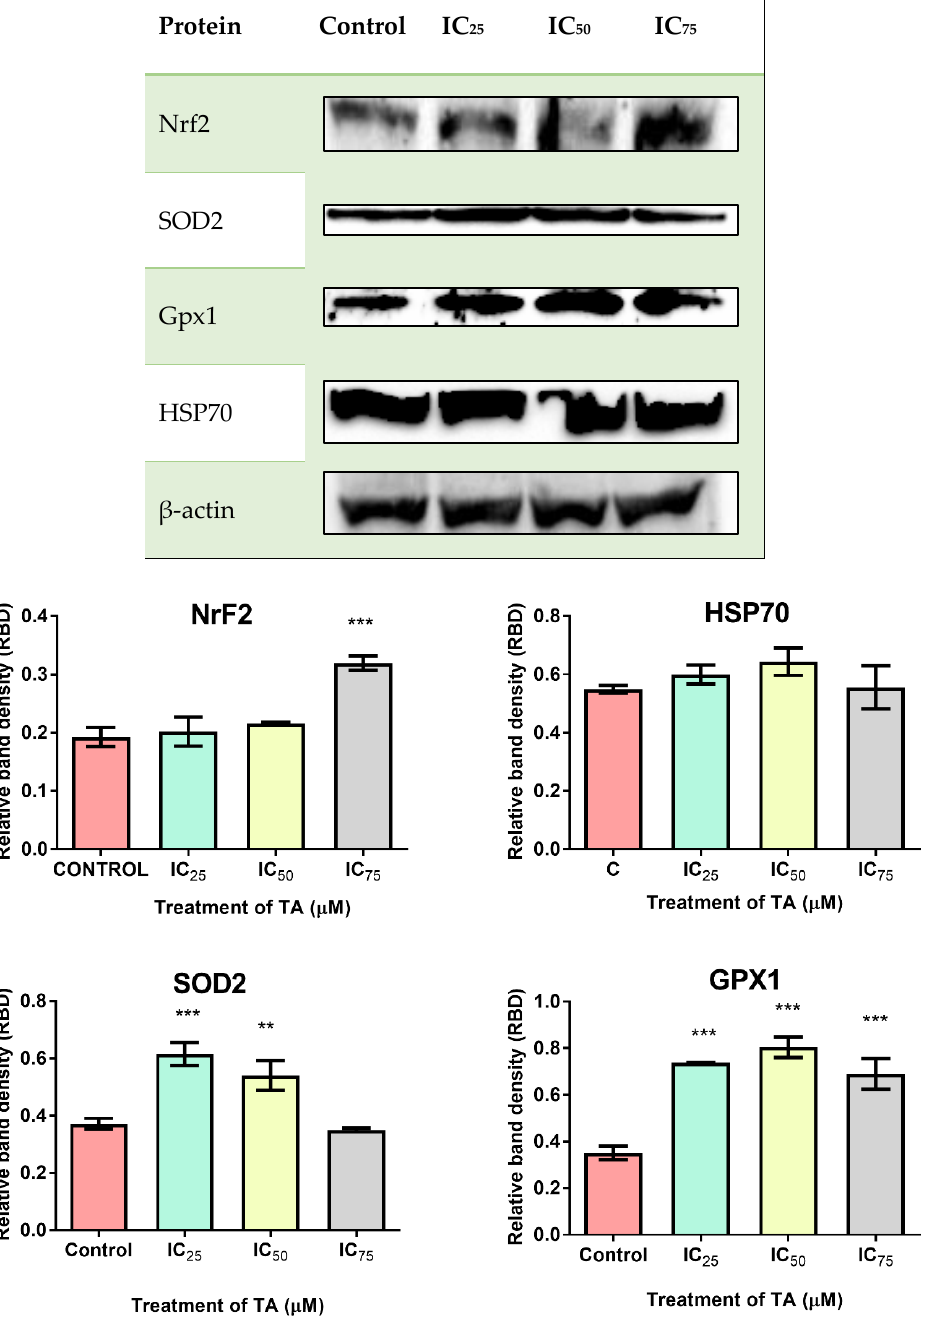
Figure 5. Differential expression of anti-oxidant and phase 2 detoxification response proteins (Nrf2, SOD2, Gpx1 and HSP70) in Hek-293 cells following treatment at IC 25 , IC 50 and IC 75 for 24 h. All treatments exhibited an upregulation in protein expressions (*** p < 0.0001, ** p < 0.05).